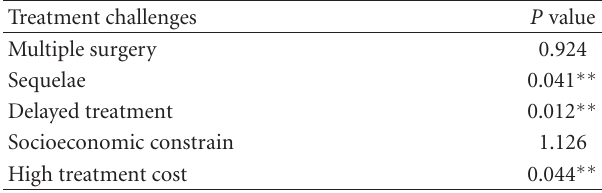
Table 5: Regression analysis of treatment